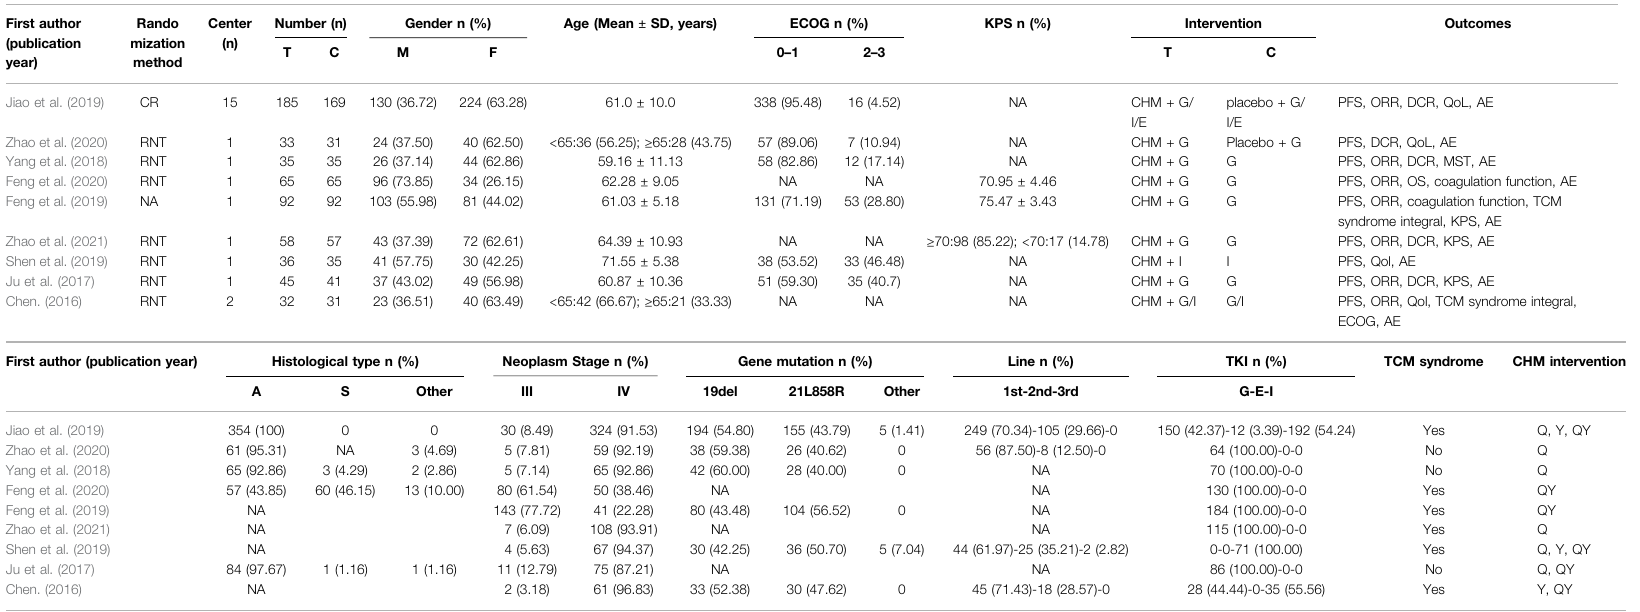
TABLE 1 | Characteristics of included